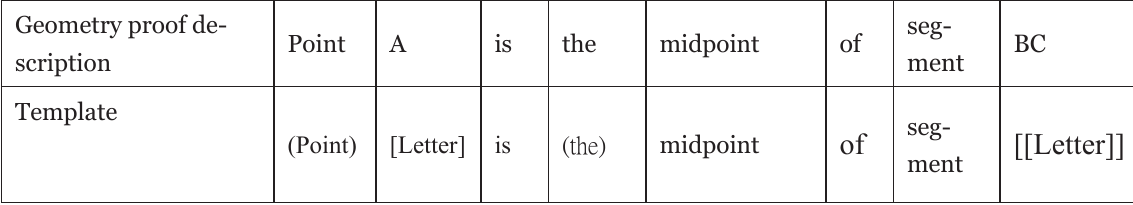
Result of Template Matching for Sentence 1 Geometry proof de-